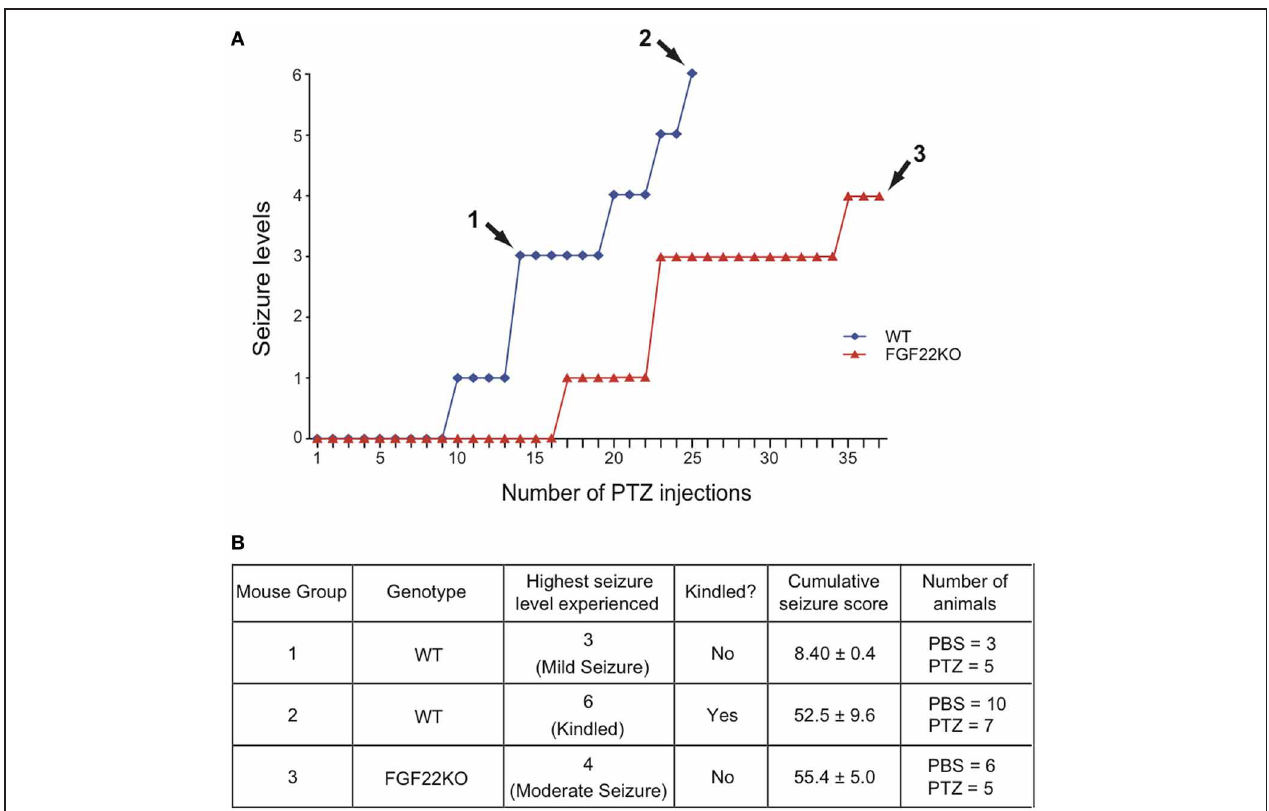
FIGURE 1 | Characteristics of the three animal groups used in this study: non-kindled WT mice with mild seizures, kindled WT mice, and non-kindled FGF22KO mice with moderate seizures. WT and FGF22KO mice were injected with a GABA receptor antagonist pentylenetetrazol (PTZ; 35mg/kg) every 48h to induce seizures. Control animals received PBS. (A) Typical time course of seizure development and three animal groups. Group 1: WT mice were injected until they first showed a seizure greater then level 1 ( ∼ 14 PTZ injections); Group 2: WT mice were injected until they were kindled ( ∼ 24 PTZ injections); Group 3: FGF22KO mice were injected with PTZ for 37 times—they showed moderate seizures but did not kindle. (B) Summary of characteristics of